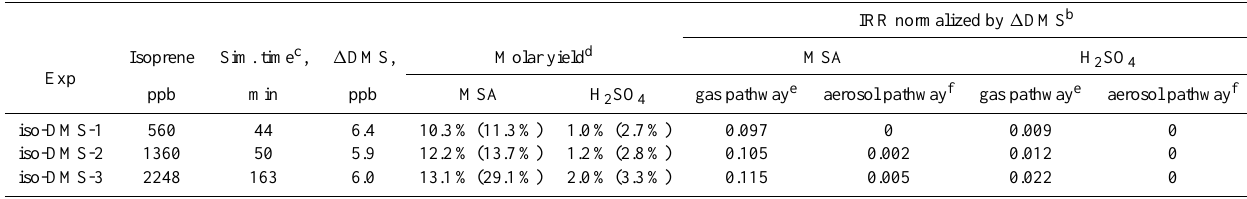
Table 3. Model simulation of the yields of MSA and H 2 SO 4 and the integrating reaction rates (IRR) of the formation of MSA and H 2 SO 4 in the presence of different amount of isoprene a